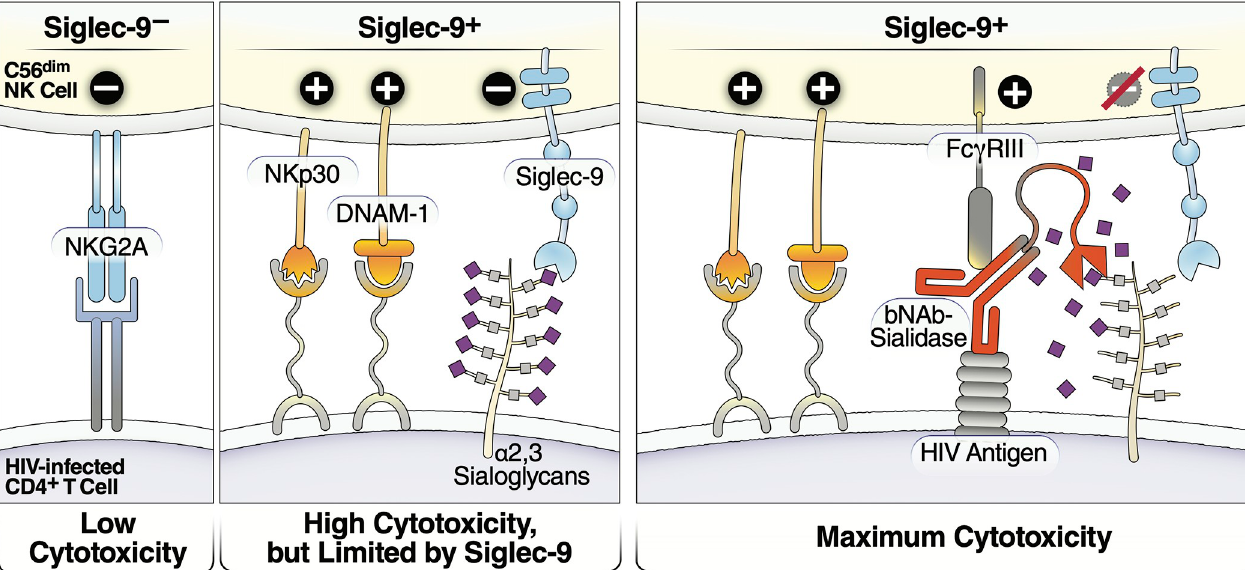
Fig 10. Model of how HIV bNAb-Sialidase conjugates may increase the cytotoxicity of Siglec-9 + NK cells against HIV-infected cells. Left two panels: The Siglec-9 + CD56 dim NK subset has high cytolytic activity, possibly due to elevated expression of several NK activating receptors and reduced expression of the inhibitory NKG2A, compared to Siglec-9 - CD56 dim NK cells. However, Siglec-9 itself is an inhibitory receptor whose signaling restrains the cytolytic ability of these otherwise highly cytotoxic Siglec-9 + CD56 dim NK cells by binding to Sialic acid attached to protein or lipid backbones on the surface of target cells. Right panel: Siglec/Sialic acid interactions are being pursued as an approach to enhance NK cell cytotoxicity against cancer using antibodies conjugated to Sialidase. We developed a similar proof-of-concept approach–conjugating Sialidase to HIV bNAbs–that could be used in conjunction with strategies that reactivate HIV latently-infected cells to enhance NK cells’ capacity to clear HIV+